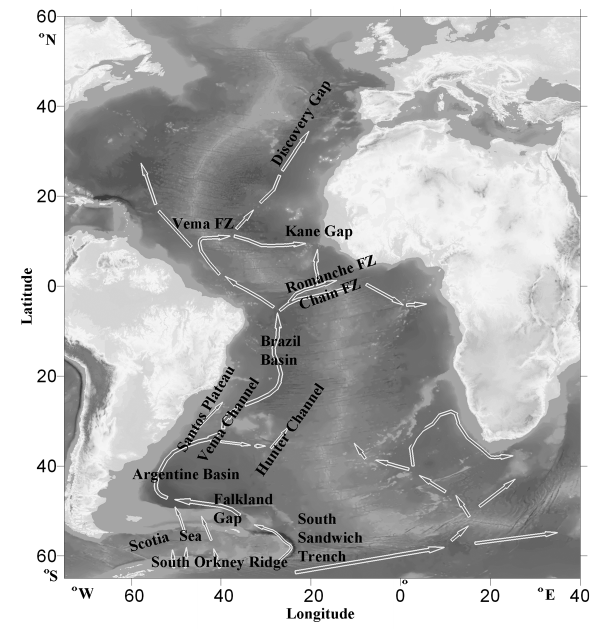
Fig. 1. Scheme of AABW propagation in the Atlantic Ocean.